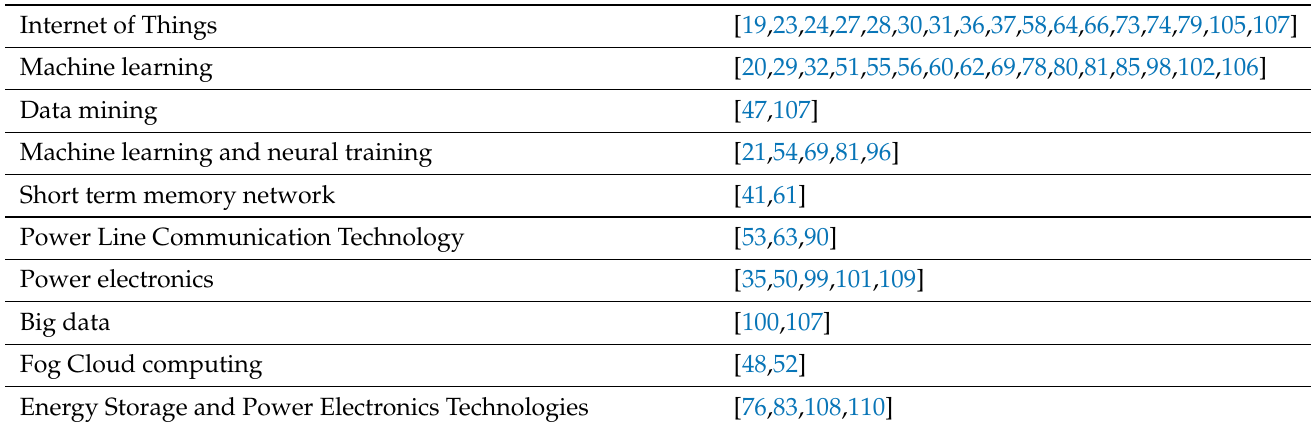
Table 2. Articles that can be classified as smart grid technologies.